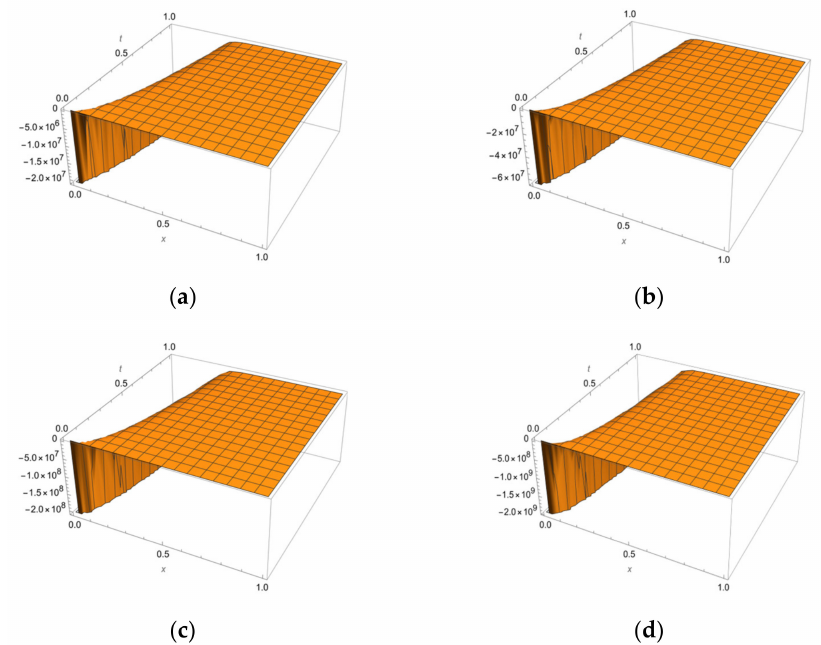
Figure 4. The graph of the surface solution f ( x , t ) for the IVP at p = 1.2 and α = 1 in Example 3.